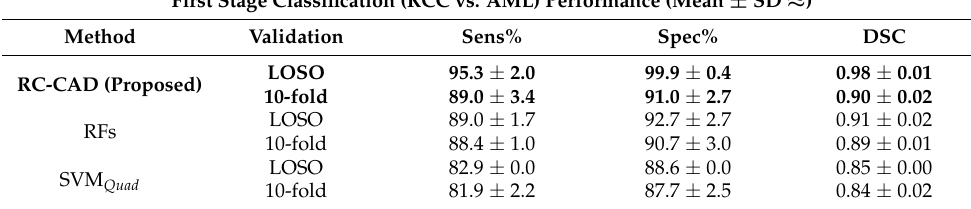
Figure 9. A difficult case presentation showing the textural differences, wash-in and wash-out slope differences, and shape differences between two ccRCC, two nccRCC, and two AML renal tumors. Table 5. Diagnostic performance comparison for both classification stages between the developed RC- CAD system and other classification approaches (e.g., random forest (RF) and support vector machine (SVM)). Using leave-one-subject-out (LOSO) and a randomly stratified 10-fold cross-validation approach, the diagnostic abilities of the RC-CAD outperformed the others. Let Sens: sensitivity, Spec: Specificity, DSC: Dice similarity coefficient, and Acc: